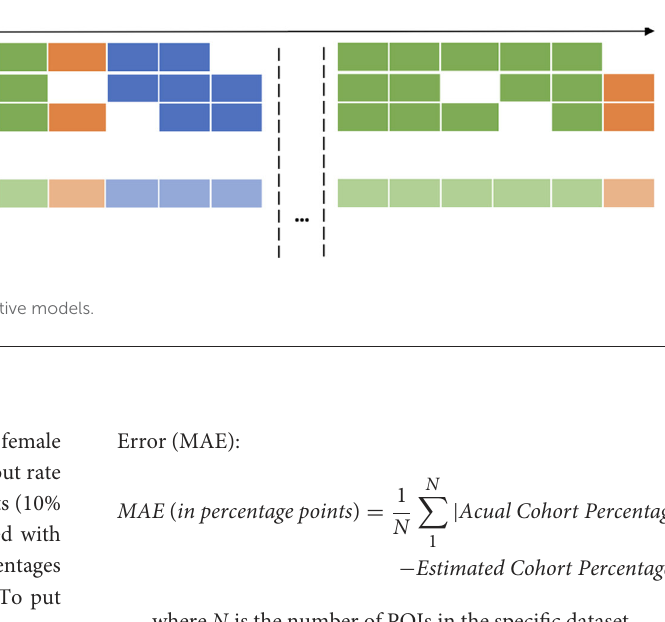
count 90 out of 100 male participants and 45 out of 50